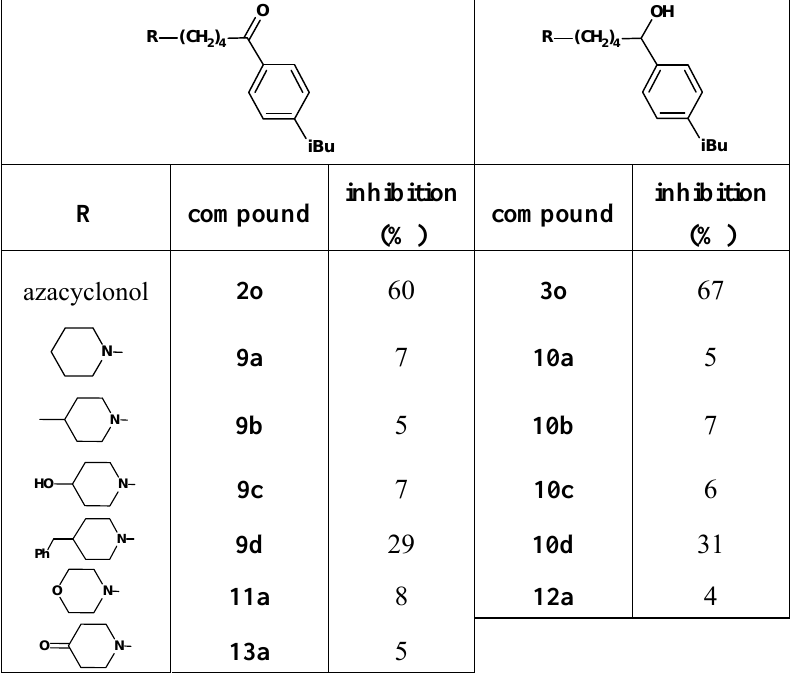
Table 6. Inhibition of protein interaction in AN assay by compounds 9a - 13a compared to compounds 2o and 3o (concentration: 50 µM, standard deviation ≤ 6 %). (CH 2 ) 4